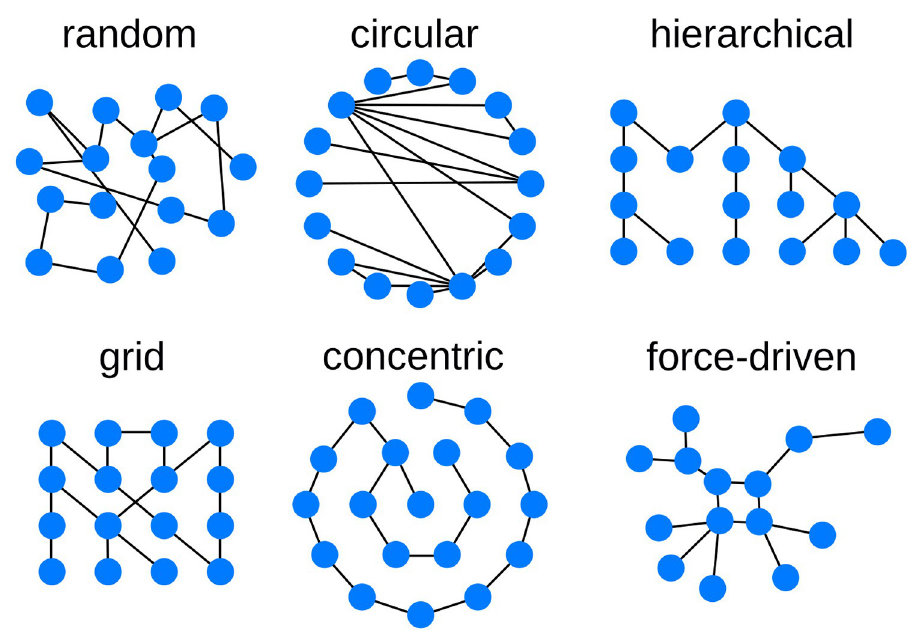
Fig 5. Available graph layout options. Different layout algorithms determine the position of each node, and therefore the overall representation of the